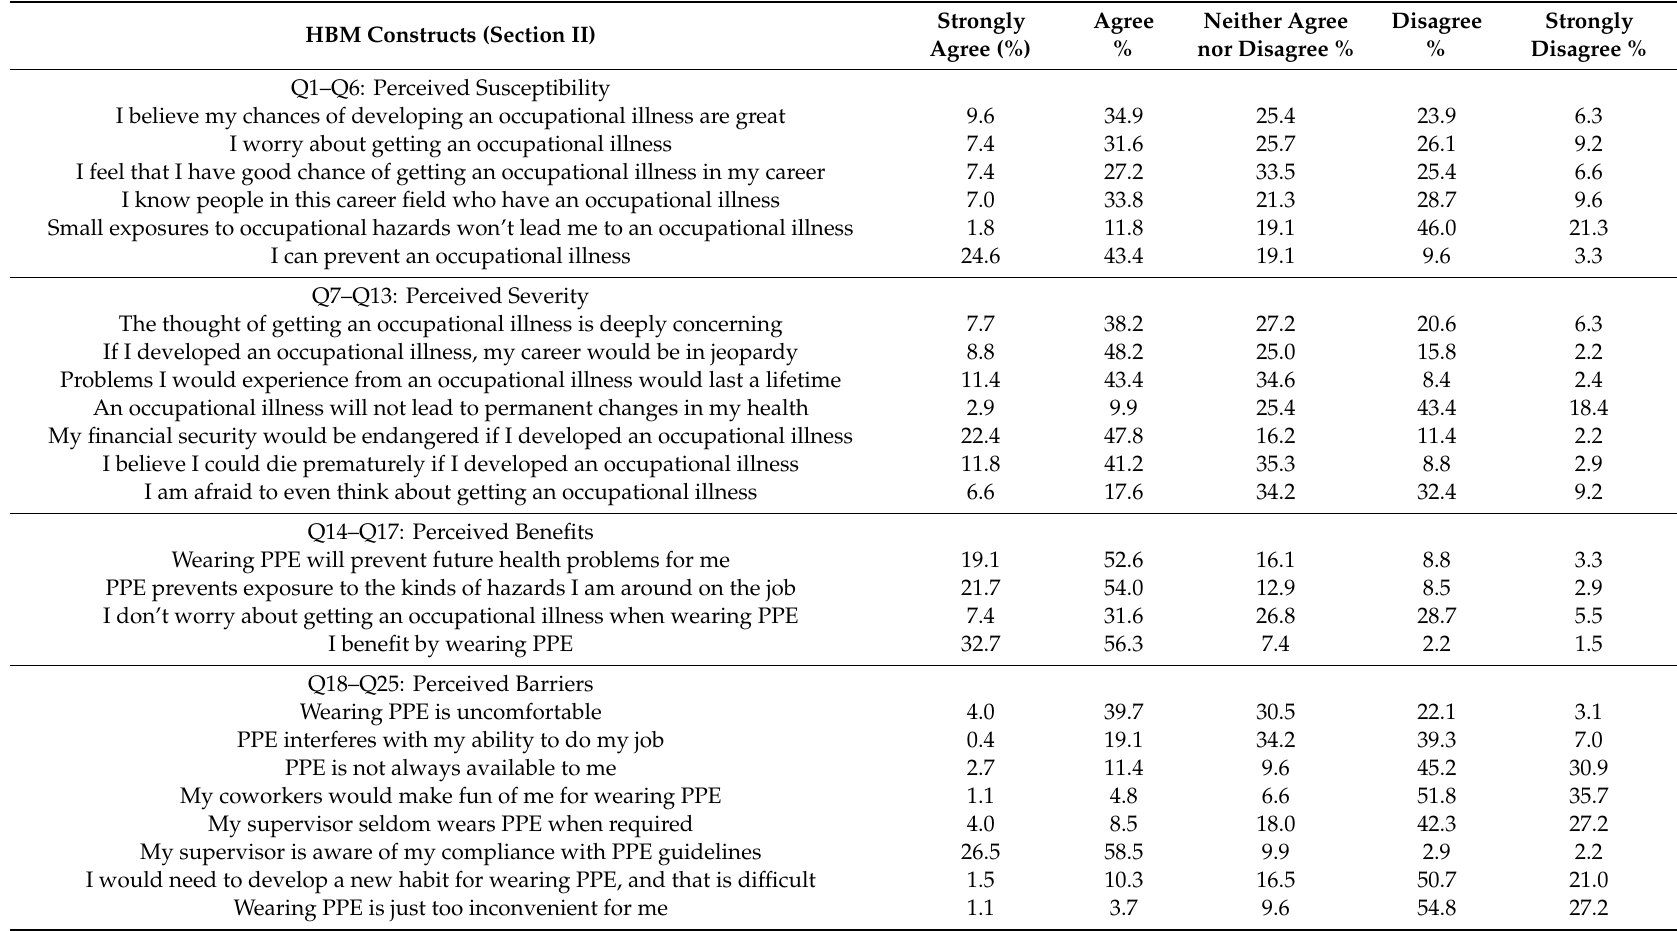
Table 3. Percentage distribution of participant’s responses from the Health Belief Model constructs ( n =